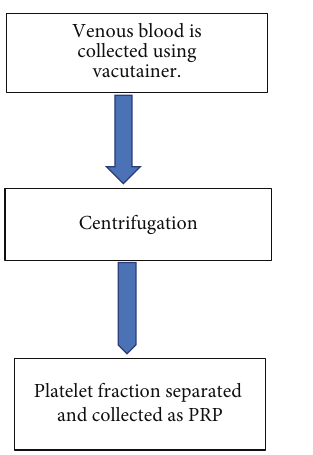
Figure 1: Preparation of